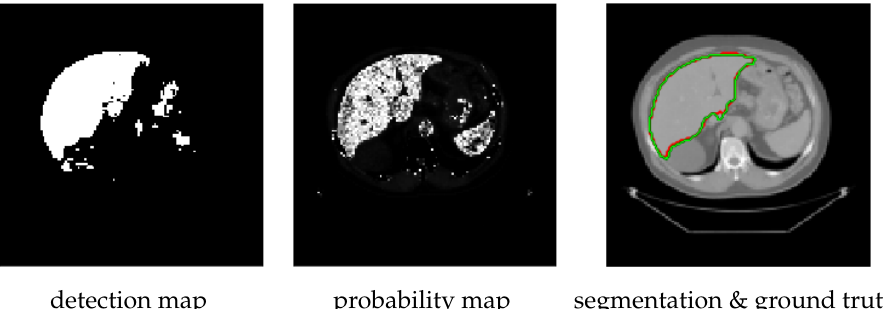
Figure 4. Example of a detection map ( D ), probability map ( I ), 3D CVNN-UNet segmentation result (green) and ground truth (red) of a CT slice from the BTCV dataset.